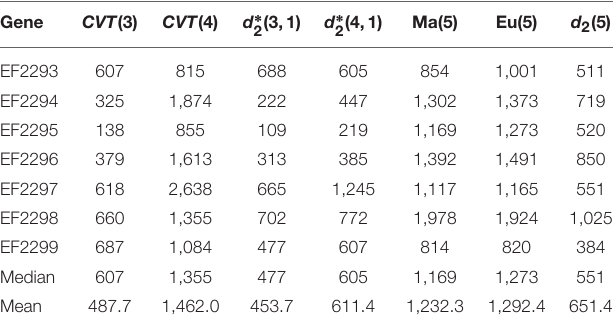
The first to seventh rows show the ranks of EF2293-EF2299 among all E.faecalis V583 genes calculated by different methods. The eighth and ninth rows show the median and mean of the ranks of the seven